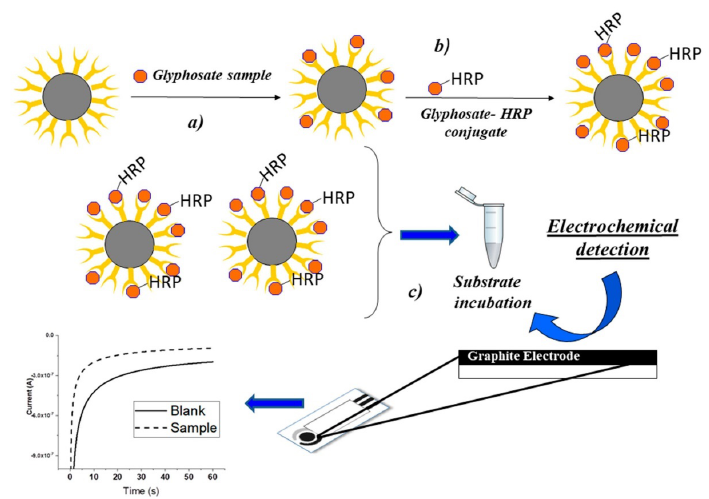
Figure 11. Electrochemical immunoassay coupled with disposable screen-printed carbon electrode: ( a ) Paramagnetic beads modified with anti-glyphosate antibodies were incubated with samples; ( b ) a solution containing horseradish peroxidase (HRP) conjugate was added; ( c ) after several washing steps, the particles were magnetically blocked, and the substrate was added. The enzymatic product was measured by chronoamperometry[129]. Free use. Copyright 2018 MDPI.